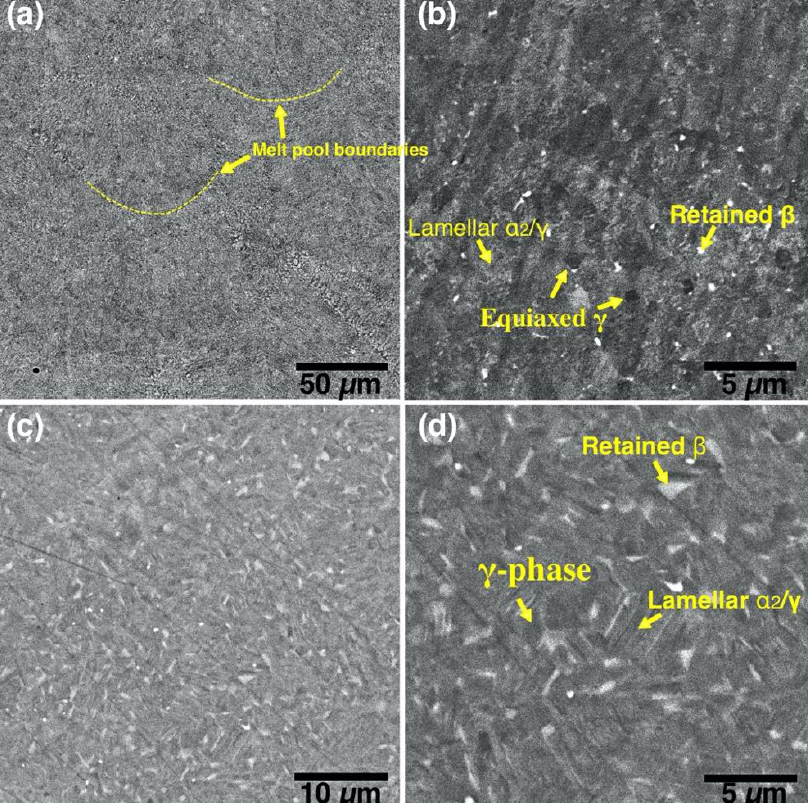
Figure 9. Backscattered electrons (BSE) SEM images showing microstructures of the samples fabricated from GA powder at ( a , b ) 800 °C (sample 5_800) and ( c , d ) 900 °C preheating temperature (sample 5_900).